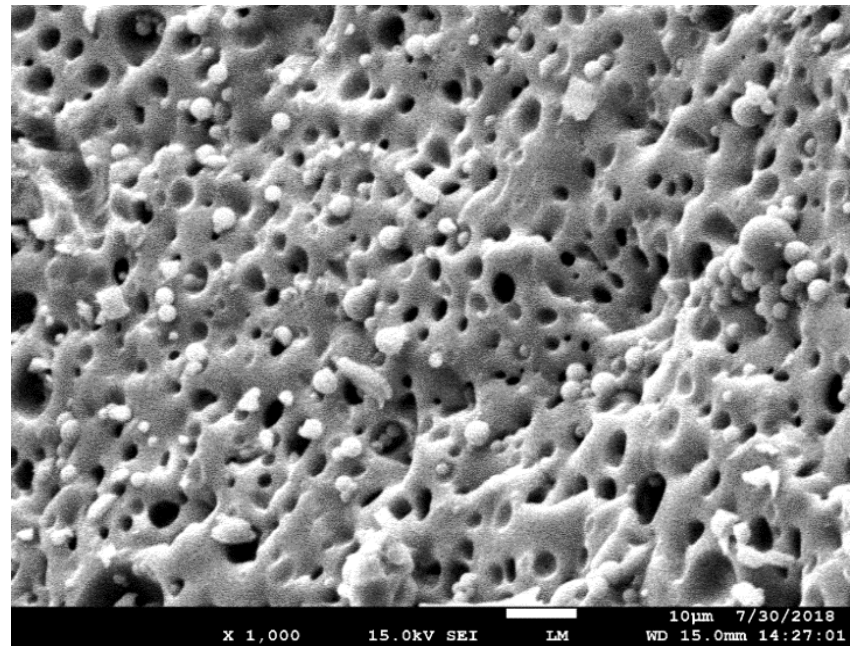
Figure 9. Field emission scanning electron microscopy (FESEM) images of adsorbent 2 before Figure9. Fieldemissionscanningelectronmicroscopy(FESEM)imagesofadsorbent 2 adsorption.